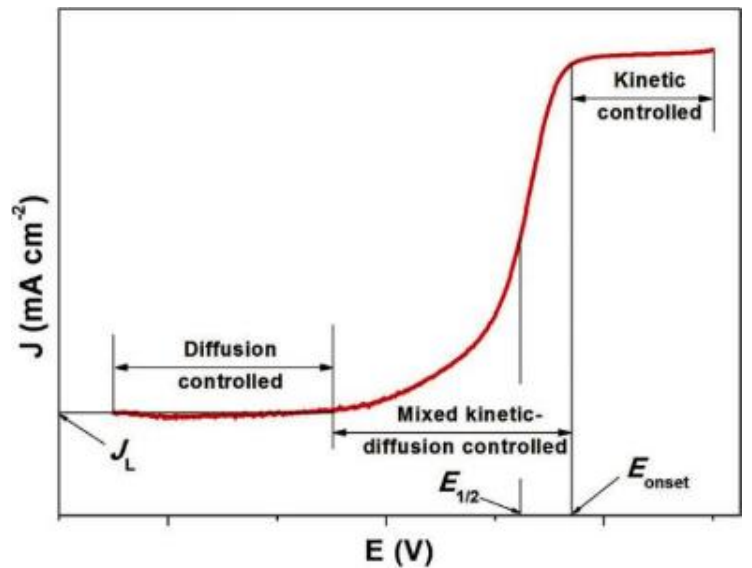
Figure 2. Typical ORR polarization curve showing the definitions of the onset potential ( E onset ), half-wave potential ( E 1/2 ), and diffusion-limited current density ( J L ). Reprinted with permission from ref. [33]. Copyright (2015) John Wiley and Sons.